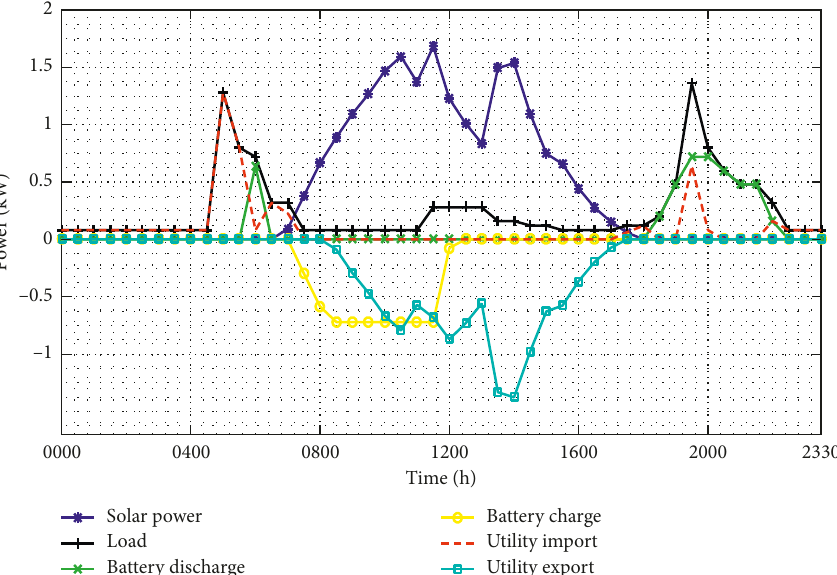
Figure 8: Power source operation for optimization problem (MILP) simulation.